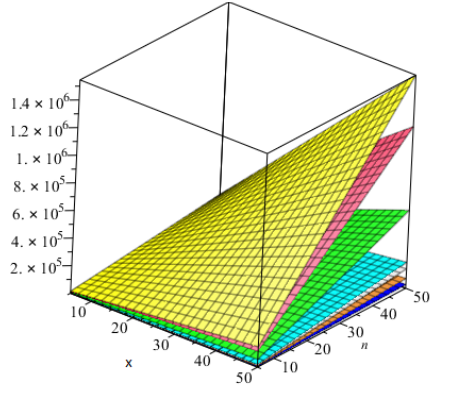
In addition, ISI index and forgotten index has much better predictive power than the predictive power of the Randić index, so the ISI index and forgotten index is more useful than the Randić index for α ∈ { −1, −1/2 } as compared to the Randić index for α ∈ { 1, 1/2 } in the case of HDN 1( n ) and HDN 2( n ) . Since the first and second Zagreb indexes were found to occur for computation of the total π -electron energy of the molecules, in the case of HDN 1( n ) and HDN 2( n ), their values provide total π -electron energy in increasing order for higher values of n